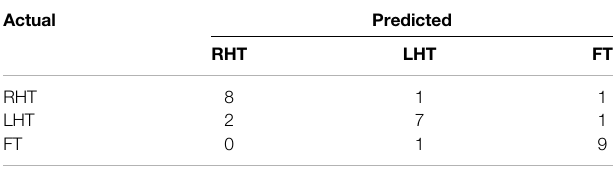
Frontiers in Big Data |